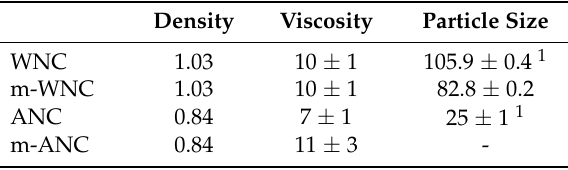
Table 3. Main properties of the products (WNC, ANC) and respective matrices (m-WNC and